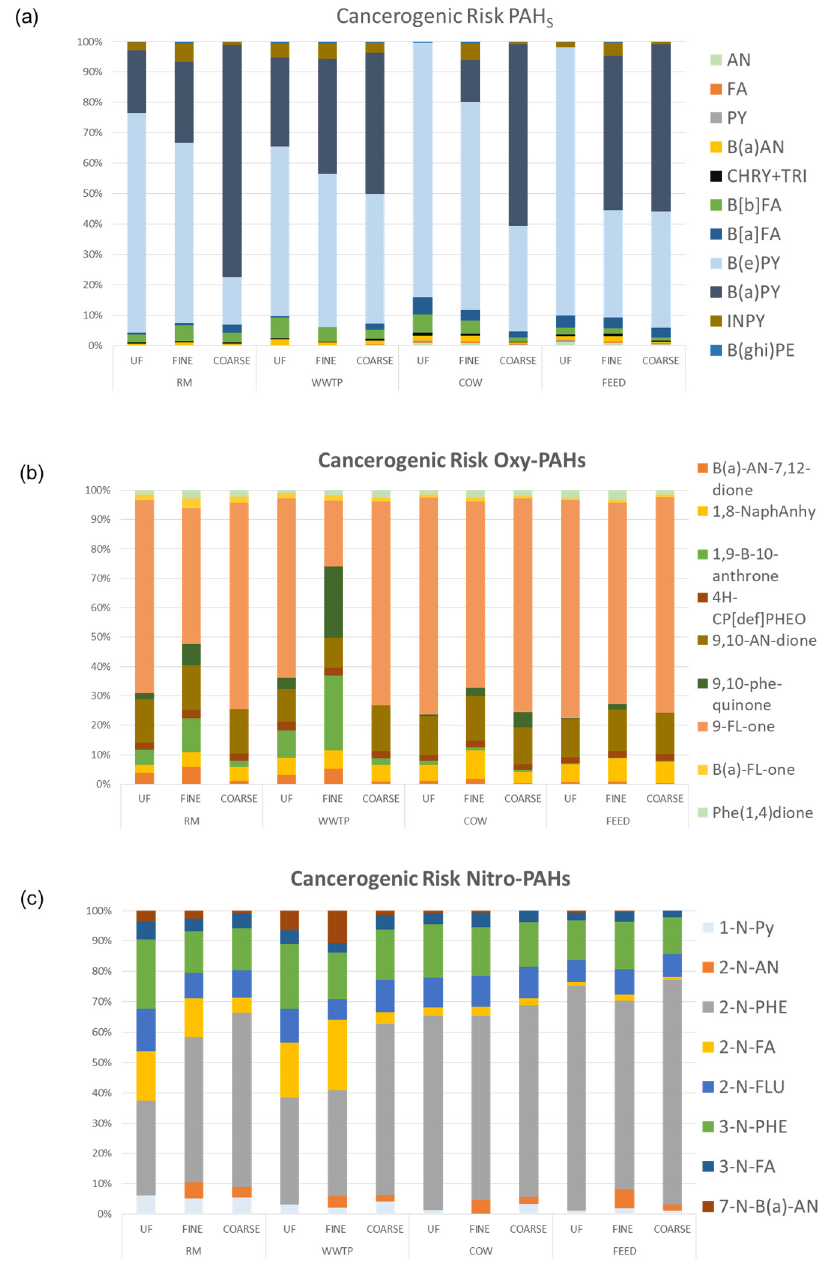
Figure 10. Percentage distribution of carcinogenic risk of PAHs ( a ), Oxy- ( b ) and Nitro-PAHs ( c ) in ultrafine, fine and coarse fraction of PM in the four sampling sites.